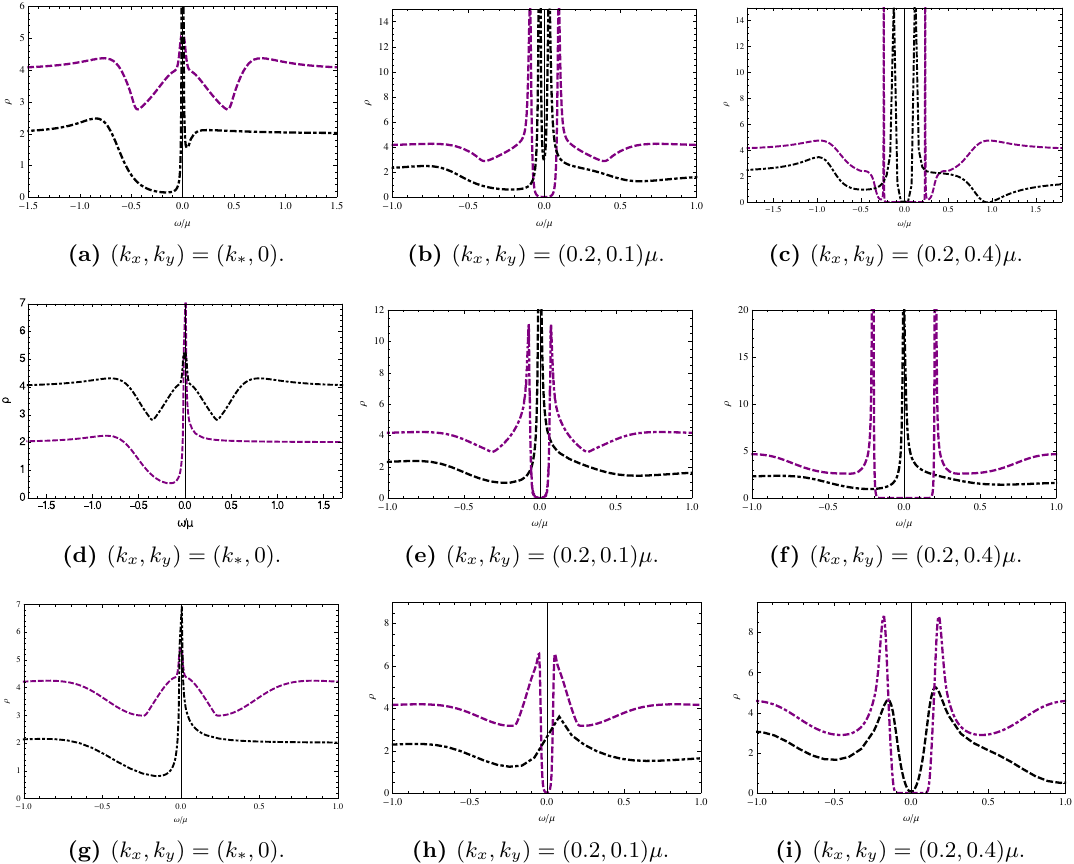
Figure 4. The spectral function as function of ! in the normal (black) and superconduct- ing (purple) phases, at (cid:12)xed ( k x ; k y ), for three di(cid:11)erent temperatures and